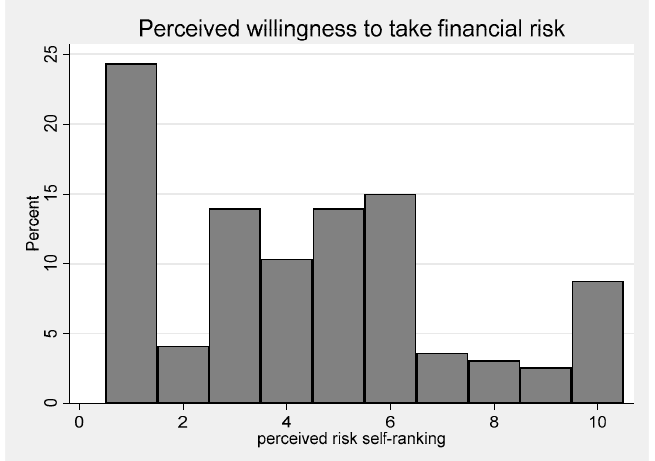
Figure 1. Perceived willingness to take financial risk (PWTFR) graph, shows percentages of self- reported PWTFR rankings made by the respondents on a 10-point Likert Scale. Perceived risk self-ranking ‘ bar 1 ’ shows subjects who self-reported that they are ‘ very willing ’ to take financial risk in the investments while ‘ bar 10 ’ shows percentage of subjects ‘ not willing ’ to take financial